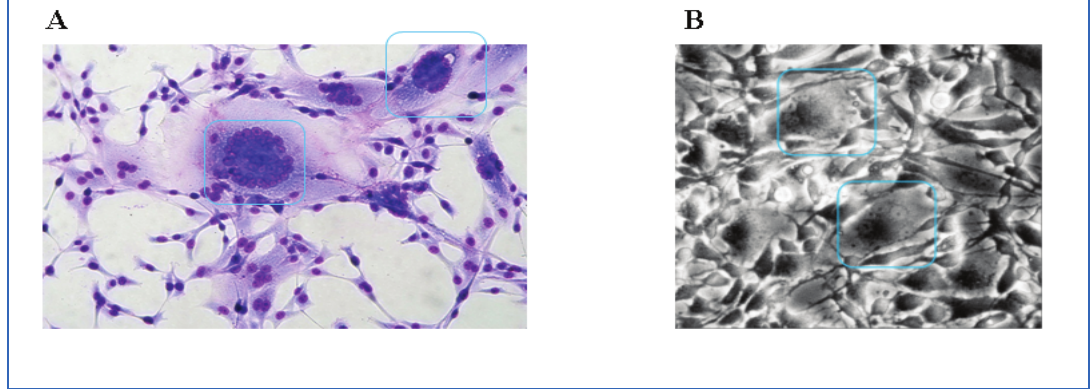
Figure 8. ( A ) Characteristic cytopathic effect observed in BFV-infected canine thymus cells (Cf2Th). Blue boxes frame multinucleated cell fusions (syncytia formation) which are characteristic for BFV-infected Cf2Th cells. Cells have been Giemsa stained; ( B ) Syncytia formation in FFV infected Crandell feline kidney (CRFK) cells, as seen by phase contrast microscopy. Blue boxes indicate cell fusions with multiple nuclei (by courtesy of Anne Bleiholder for ( B